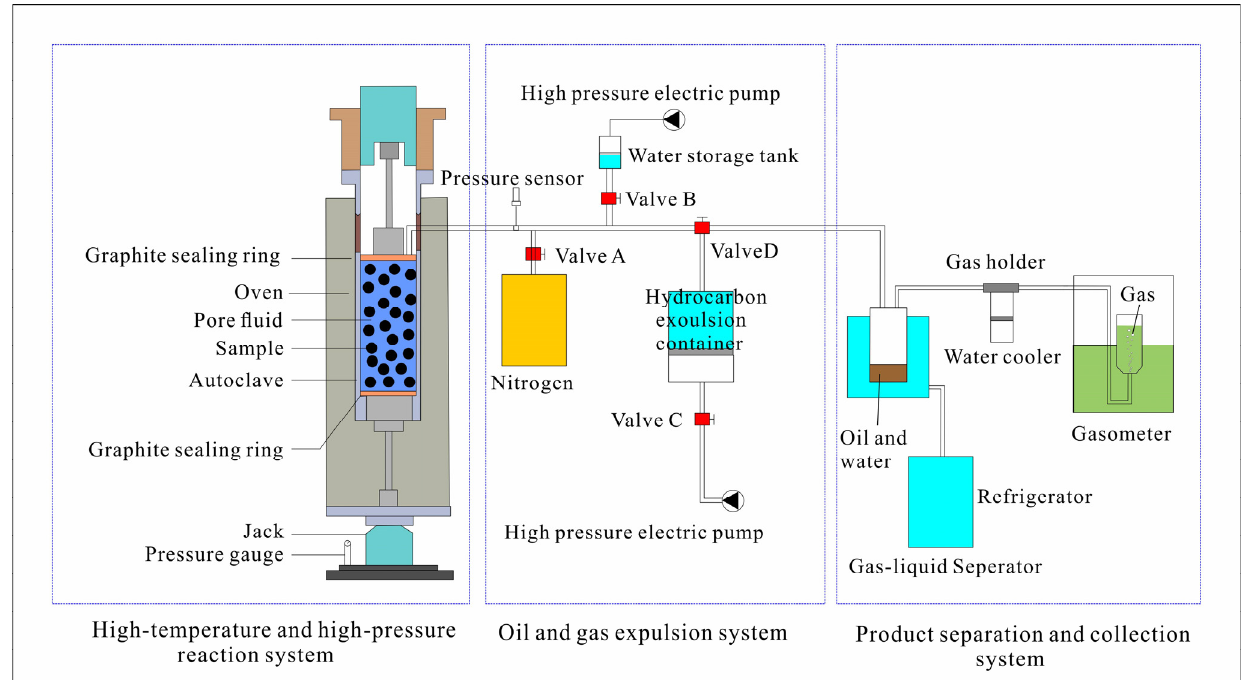
Figure 2. Schematic diagram of semi–closed hydrous pyrolysis apparatus (modi fi ed from Ma et al. Schematic diagram of semi–closed hydrous pyrolysis apparatus (modified from [26]). Ma et al.